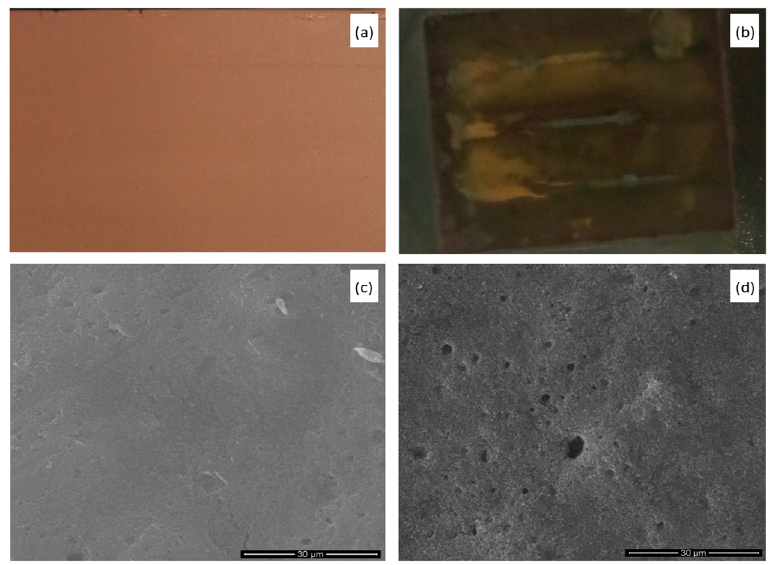
Figure 2. Photographic ( a , b ) and SEM ( c , d ) images of copper-sputtered GDE before ( a , c ) and after ( b , d ) 80 min-long electrocatalytic tests performed at the current density of 200 mA · cm − 2 .